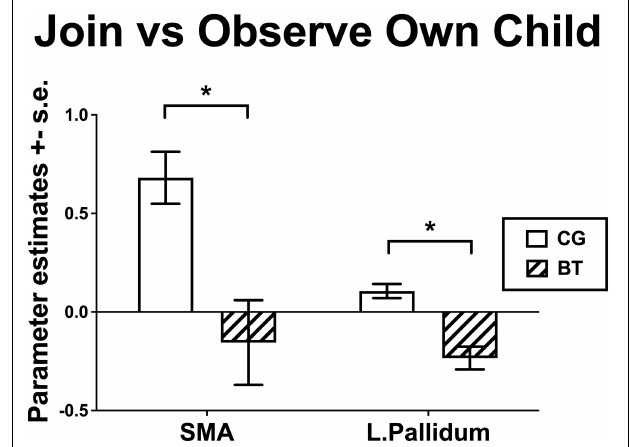
FIGURE 5 | The bar charts for the Join vs. Observe of Own Child differential responses of BT and CG groups (mean ± s.e.) in the SMA and left pallidum. *indicates that significant group difference in the fMRI analysis.